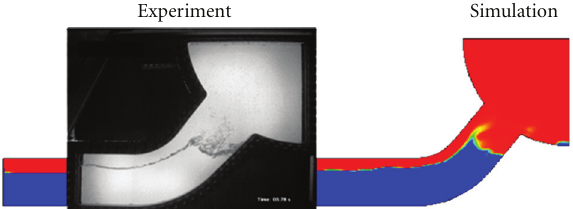
Figure 7: Snapshot of the results of the calculations.